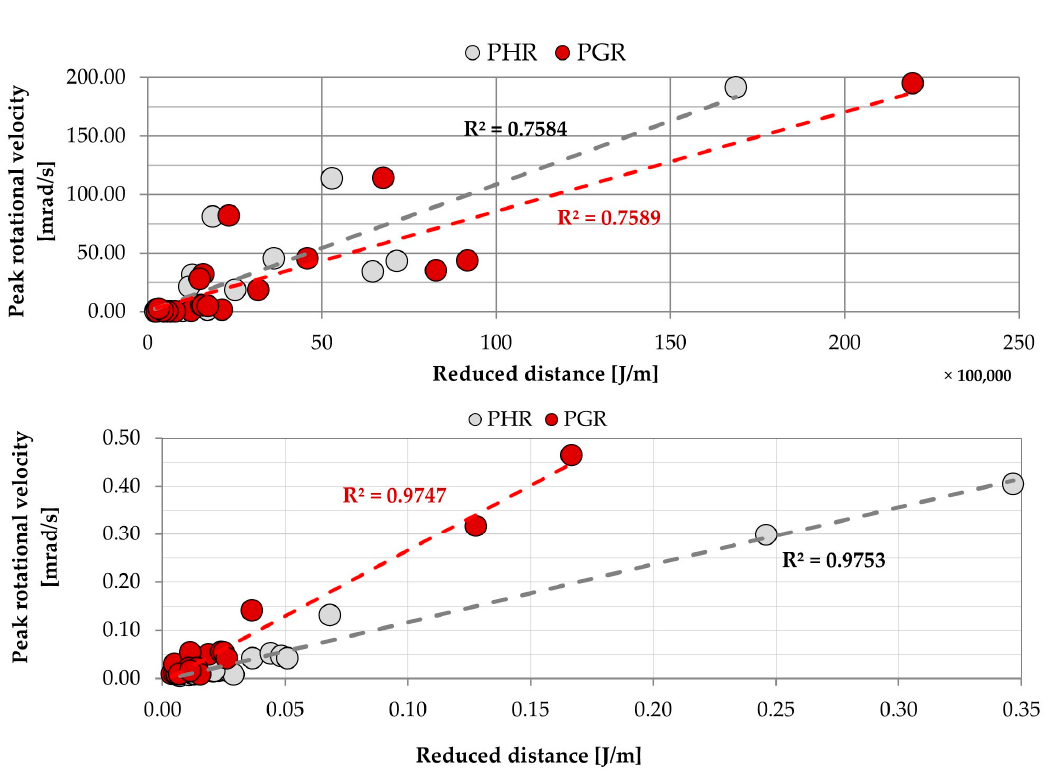
Figure 14. The relation between R E–D and recorded rotational velocity at the Rudna-I measuring site Figure 14 ( top ) and Zelazny Most ( bottom